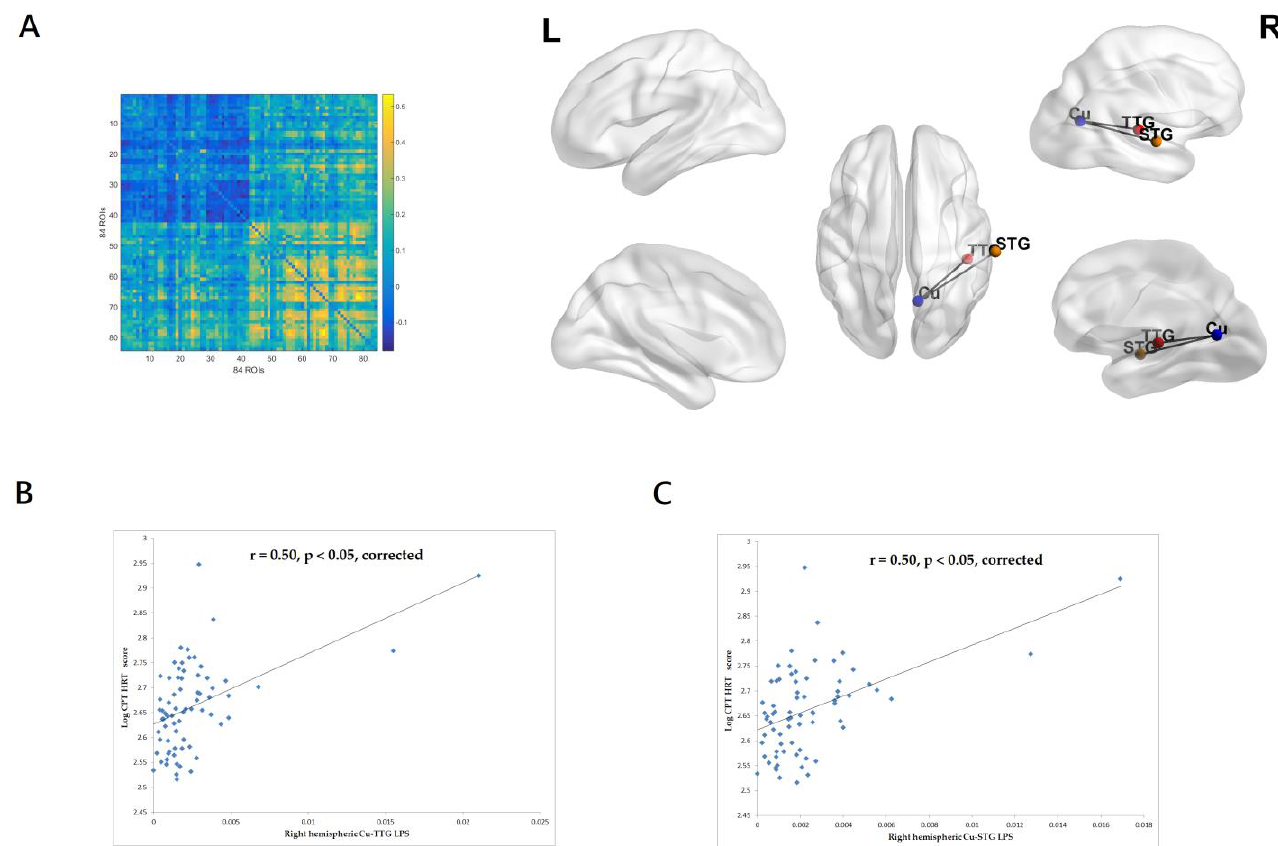
Figure 2. ( A ) Left panel: the matrix of the correlation coefficients for the value of gamma-band (33–45 Hz) lagged phase synchronization (LPS) of all pairs from 84 regions of interest. Right panel: the CPT-II HRT score was significantly associated with the gamma-band LPS between right hemispheric cuneus (Cu) and transverse temporal gyrus (TTG) and between right hemispheric cuneus (Cu) and superior temporal gyrus (STG). eLORETA and BrainNet Viewer were used to create the figure. ( B ) The patients with higher CPT-II HRT scores had greater gamma-band EEG functional connectivity between right hemispheric Cu and TTG and ( C ) between right hemispheric Cu and STG. The linear regression line was shown to model a linear trend seen in the scatterplot.